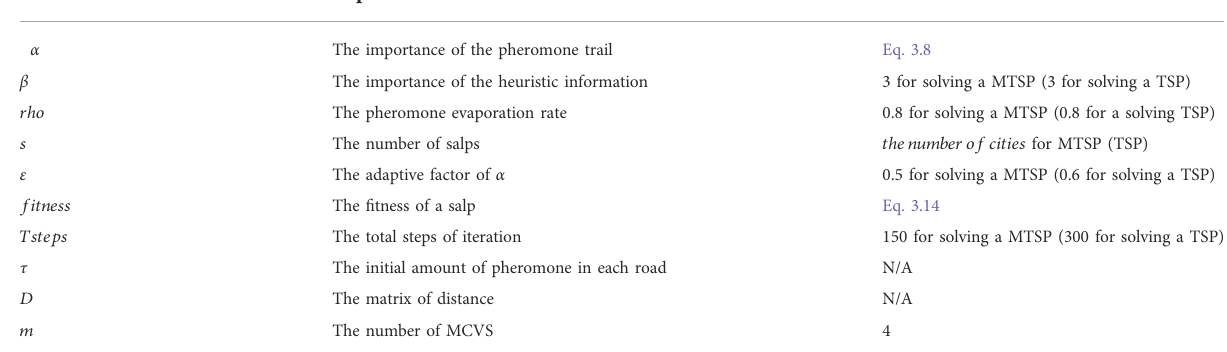
TABLE 1 The parameters of the